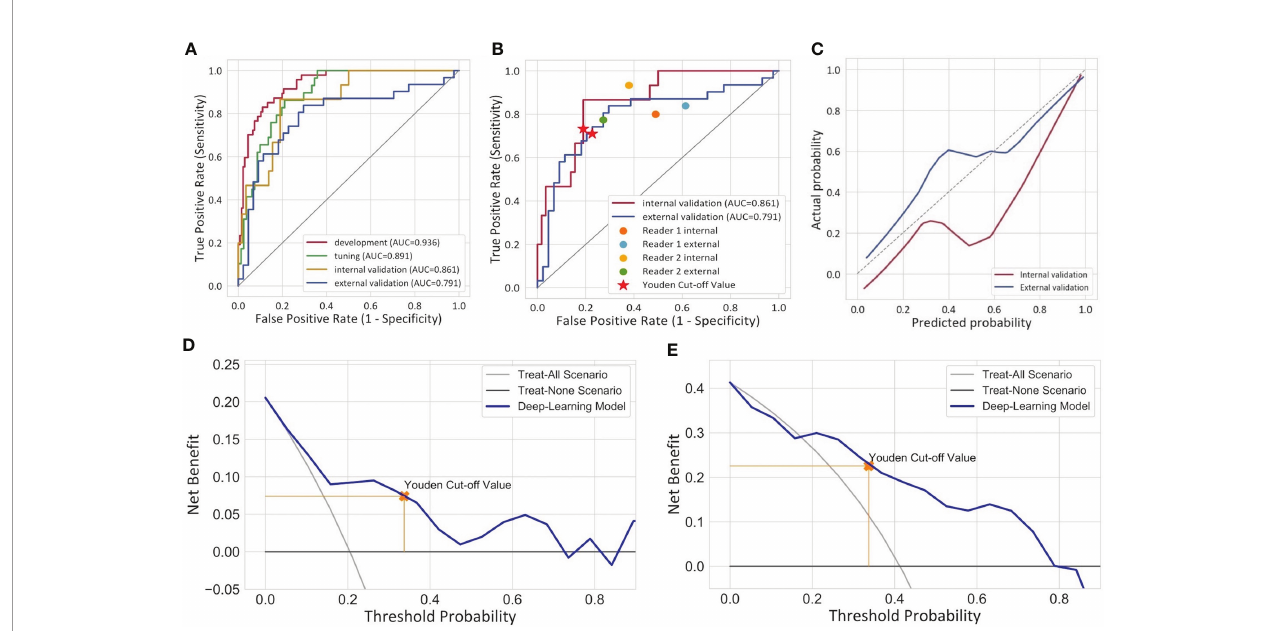
FIGURE 3 | Performance of the deep learning model for the differentiation of MIBC and NMIBC. (A) Receiver operator characteristic curves of the model in four different cohorts. (B) Comparison of the performance between the model and two radiologists. (C) Calibration curves of the model in internal and external validation cohorts. The calibration curve showed that the predicted probabilities generally agreed with the observed probabilities. The predictive performance of the model in the external validation cohort exhibited a closer fi t to the perfect calibration. (D, E) showed decision curve analyses (DCA) in the internal and external validation cohorts respectively. DCA compared the net bene fi t of the deep learning model versus treat all or treat none are shown. The net bene fi t was plotted versus the threshold probability. The net bene fi ts of the deep learning model (blue line) were superior to the bene fi ts of treating all or treating none.